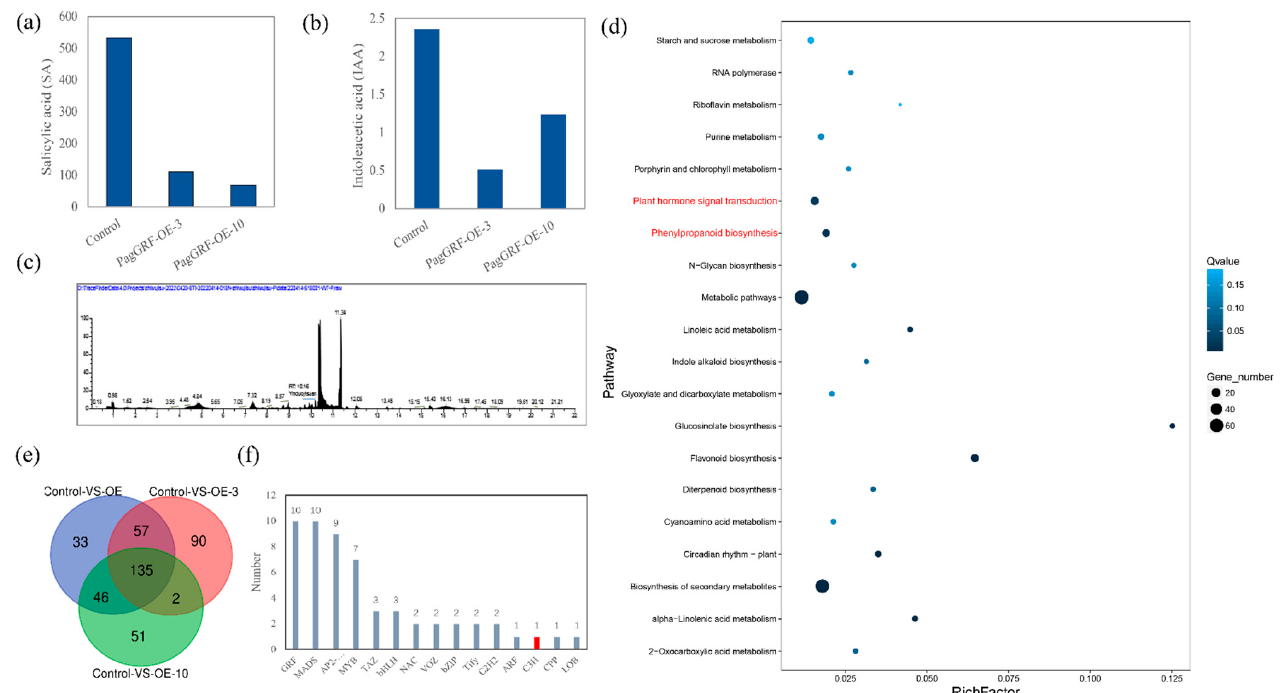
Figure 5. Transcriptome analysis of PagGRF11 overexpressing plants and control. ( a – c ) Contents of salicylic acid and indoleacetic acid in control, PagGRF-OE-3, and PagGRF-OE-10 were detected by high performance liquid chromatography. ( d ) KEGG enrichment analysis of 135 DEGs. The size of the dots represents the number of genes (the larger the dot, the more genes are enriched). The color of the dots indicates the enrichment significant level (the darker the color, the smaller the Q value, and the more significant the enrichment degree is). ( e ) Venn diagram analysis of three comparison groups: Control-VS-OE, Control-VS-OE-3, and Control-VS-OE-10.OE: PagGRF11-OE-3 and PagGRF11-OE-10 mixed samples; OE-3: PagGRF11-OE-3 lines; OE-10: PagGRF11-OE-10 lines. ( f ) All transcription factor families and numbers in the 135 differential genes; the vertical axis represents the number of transcription factors, and the horizontal axis represents the transcription factor families.